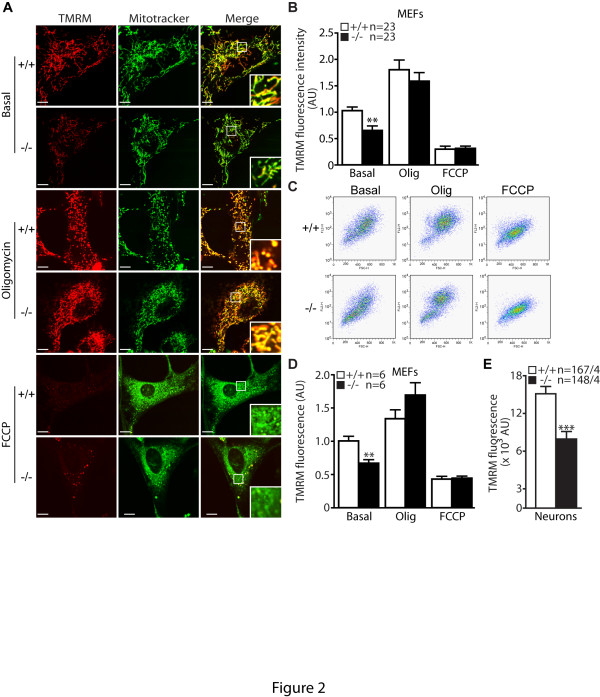
Reduced mitochondrial transmembrane potential inPINK1−/− cells. A. Representative confocal microscopic images of PINK1−/− and +/+ MEFs after staining with TMRM (50 nM, red) and Mitotracker Green (200 nM) in the presence or absence of oligomycin (Olig, 1 μM) or FCCP (10 μM). The intensity of TMRM reflects the level of mitochondrial transmembrane potential, whereas the intensity of Mitotracker Green is not affected by transmembrane potential. The bottom right inserts are the higher power views of the boxed areas in the same panel. The TMRM signal is reduced in PINK1−/− cells, whereas the TMRM signal is increased and decreased similarly in both PINK1−/− and +/+ cells following oligomycin and FCCP treatment, respectively. B. The bar graph shows quantification of TMRM signals in PINK1−/− and +/+ MEFs in the presence or absence of oligomycin and FCCP using confocal images. The number shown in the panel indicates the number of cells used in the study. C. Representative flow cytometry dot plots show the intensity of TMRM signals in PINK1−/− and +/+ MEFs following incubation with TMRM (50 nM) in the presence or absence of oligomycin (1 μM) or FCCP (10 μM). D. The bar graph shows quantification of TMRM signals measured by FACS analysis in PINK1−/− and +/+ MEFs. The number shown in the panel indicates the number of independent experiments performed. E. The bar graph of TMRM fluorescent signals in PINK1−/− and +/+ neurons shows reduced TMRM signals in PINK1−/− neurons. The numbers shown indicate the number of neurons used (left) and the number of independent experiments performed (right) in the study. All data are expressed as mean ± SEM. Scale bar: 10 μm. * p < 0.05, ** p < 0.01, *** p < 0.001.